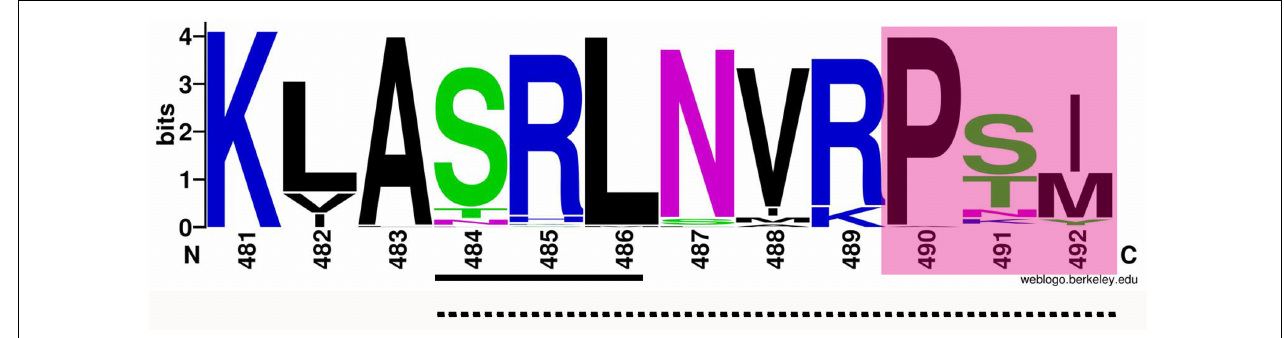
FIGURE 1 | Web-logo image of the C-termini of AcCATPO and plant catalases selected. The amino acid sequences of plant catalases selected were the same as previously reported (Teng et al., 2016). The C-terminal 12 amino acid sequences of AcCATPO and common plant catalases selected were subjected to weblogo website (http://weblogo.berkeley.edu/logo.cgi). Underlined with solid line, Conserved SRL motif; Underlined with dash line; Putative non-canonical peroxisomal targeting signal 1; Shaded, Conserved C-terminal extreme tripeptide.